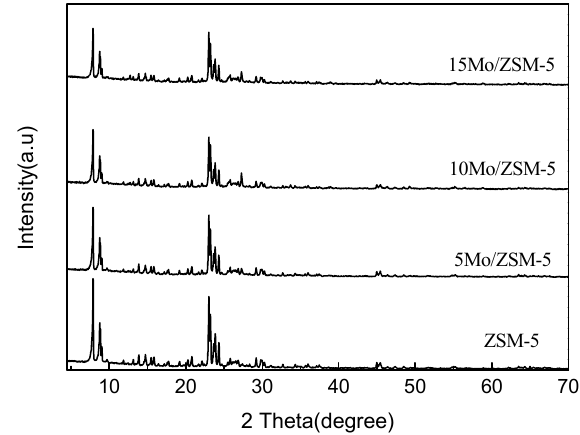
Figure 1. X-ray di ff raction (XRD) patterns of the ZSM-5 and Mo / ZSM-5